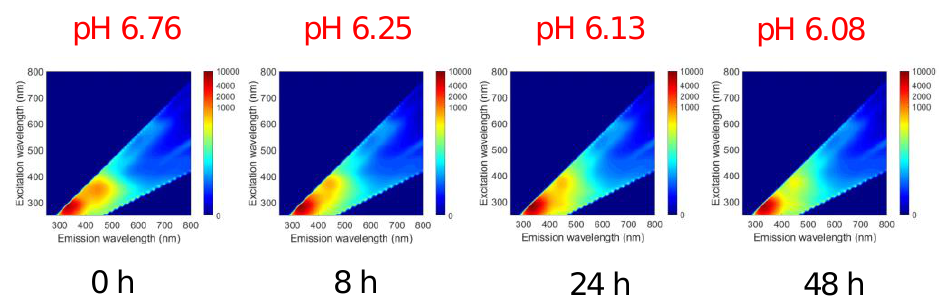
Figure 4. Representative 3D-FFs of frozen horse mackerel fish meat previously ice-stored for 0–48 h.